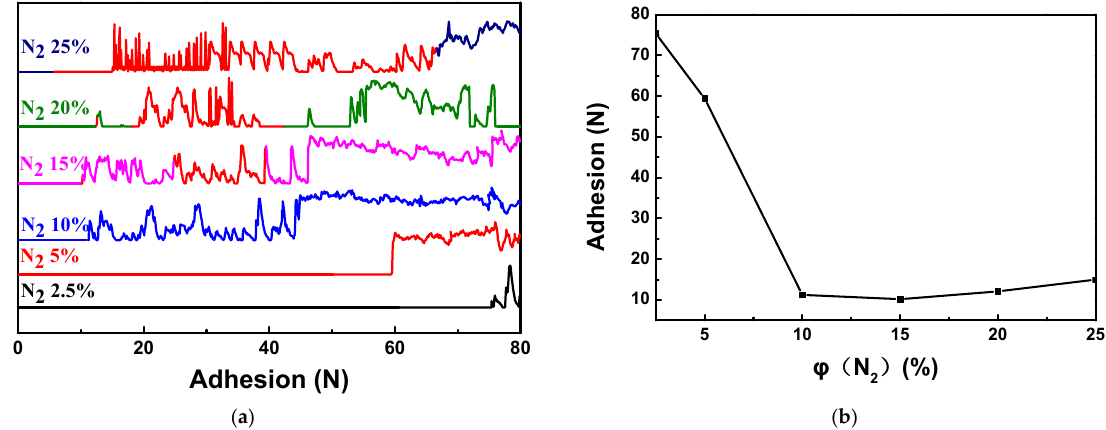
Figure 5. Different nitrogen flow ratios of TaN film on Al 2 O 3 ceramic substrate ( a ) Relationship between film-based bonding force and acoustic emission under different nitrogen flow rates, ( b ) Relationship between nitrogen flow rate and film-based bonding force.